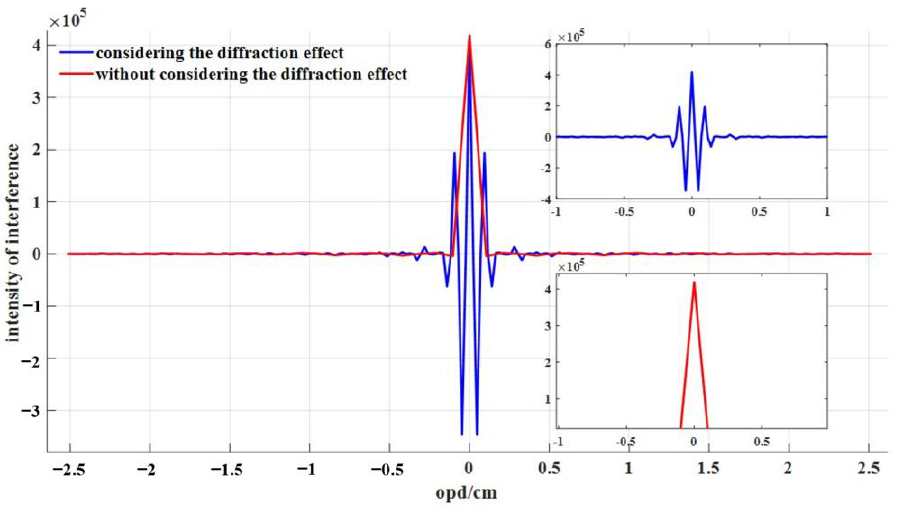
Figure 10. Interferogram of the spectrum corresponding to the fifth pixel. Insets show isolated interferogram spectrums.